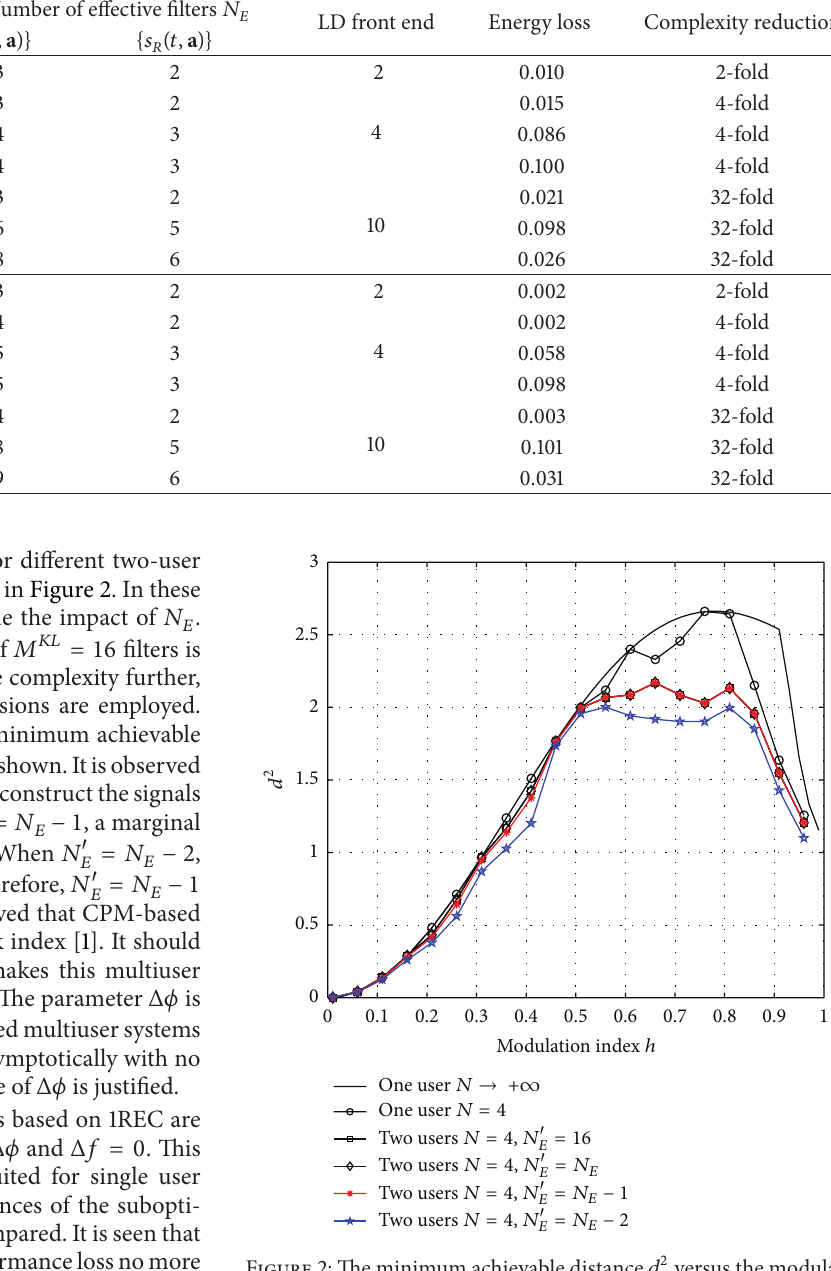
Figure 2: The minimum achievable distance 𝑑 2 versus the modula- tion index ℎ , optimum (𝐿 𝑅 = 𝐿)